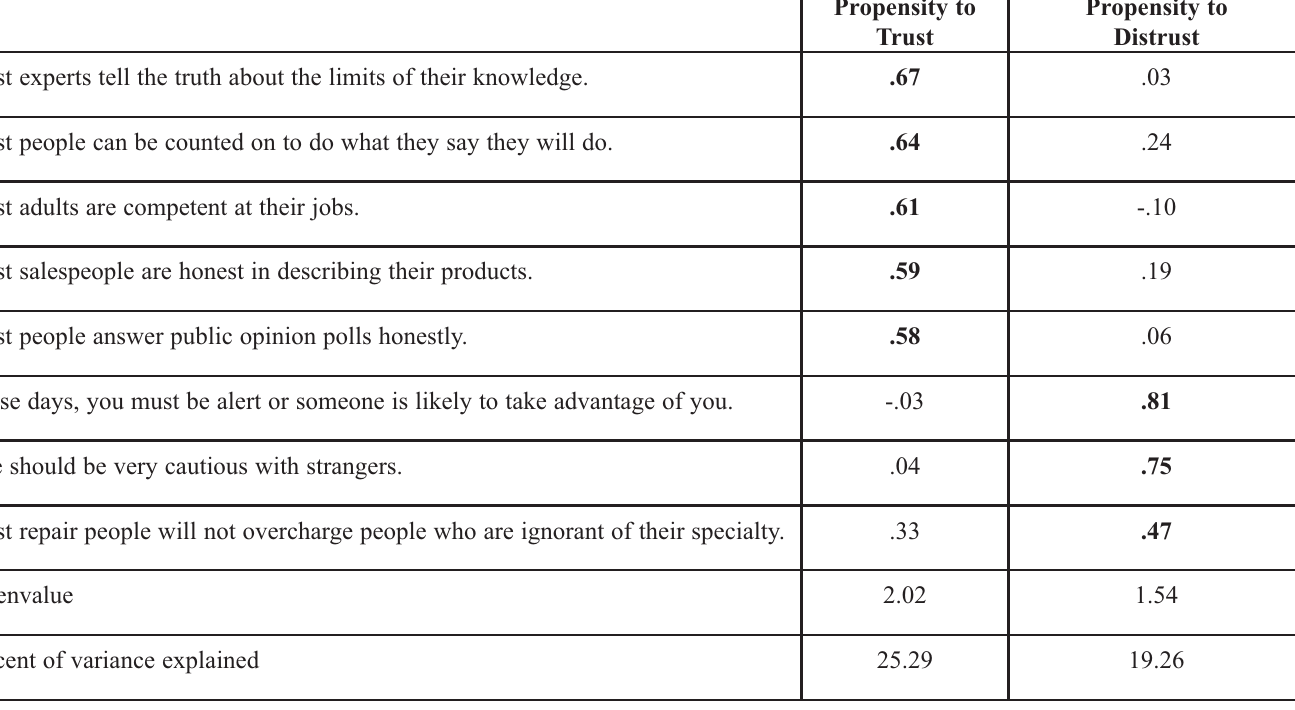
Factor Analysis Using Varimax Rotation of Propensity to Trust